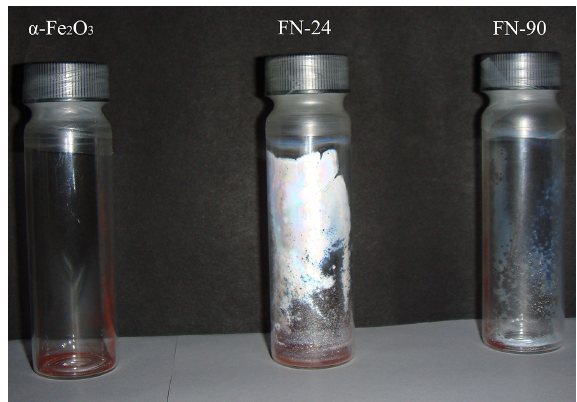
Figure 6. Digital photos of different samples after reaction with 50ppm SO 2 + 21% O 2 in the dark at 298K for about 7 days.